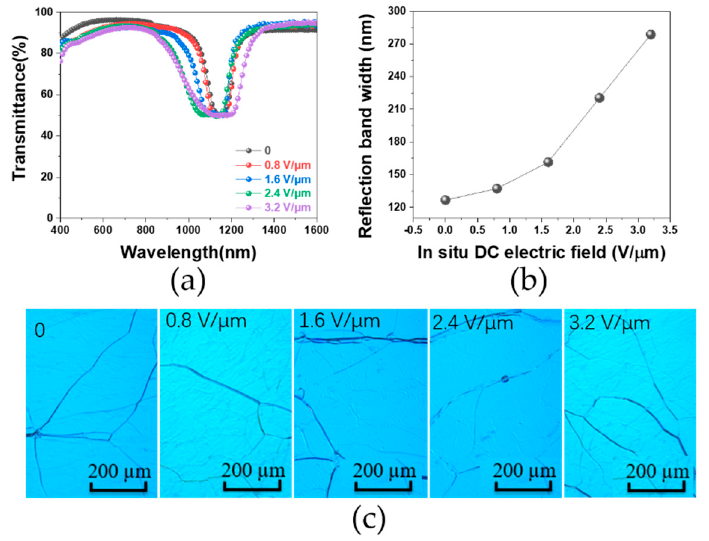
Figure 3. ( a ) Transmission spectra of polymer-stabilized cholesteric liquid crystal (PSCLC) cells treated with different in situ electric fields; ( b ) reflection bandwidth of the PSCLC cells versus in situ direct current (DC) electric field; ( c ) polarizing light microscope (POM) images of the PSCLC cells treated with different in situ electric fields.